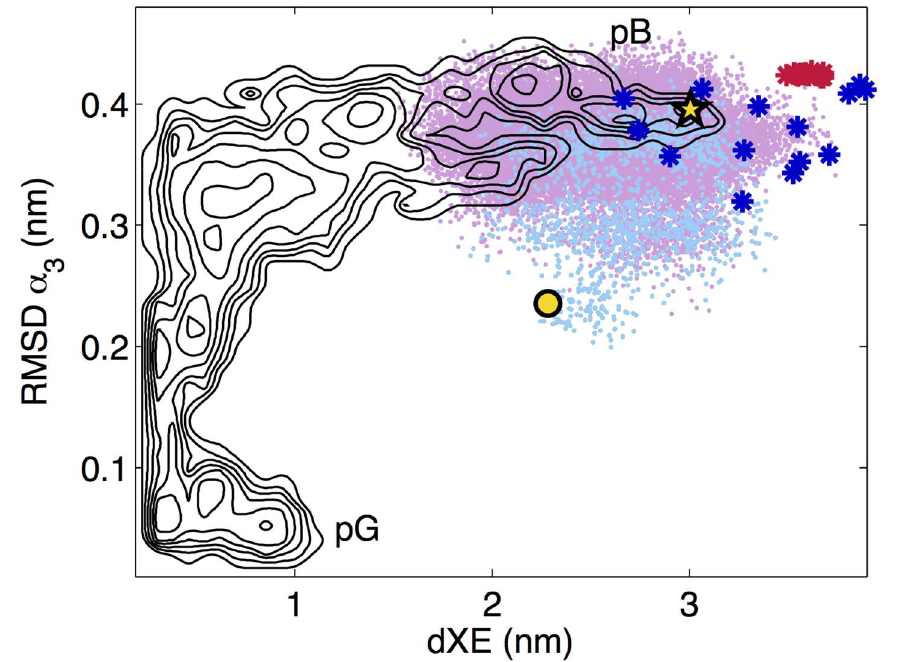
Figure 2. Diffusion Map-directed-Molecular Dynamics (DM-d-MD) and molecular dynamics (MD) results. The initial starting configuration for the DM-d-MD is denoted by the gold circle. The DM-d-MD frontier points are shown in pink, and the minimum-energy frontier point is denoted by a gold star. The MD results from approximately 100 trajectories initiated from the minimum-energy DM-d-MD frontier point are shown in light blue. For reference, the coordinates for the experimental D 25 (PDB ID 1XFQ) structures are shown as dark blue *, and the experimental WT- PYP (PDB ID: 2KX6) structures as red *. The underlying grey contours are those from Figure 1 of reference [34].